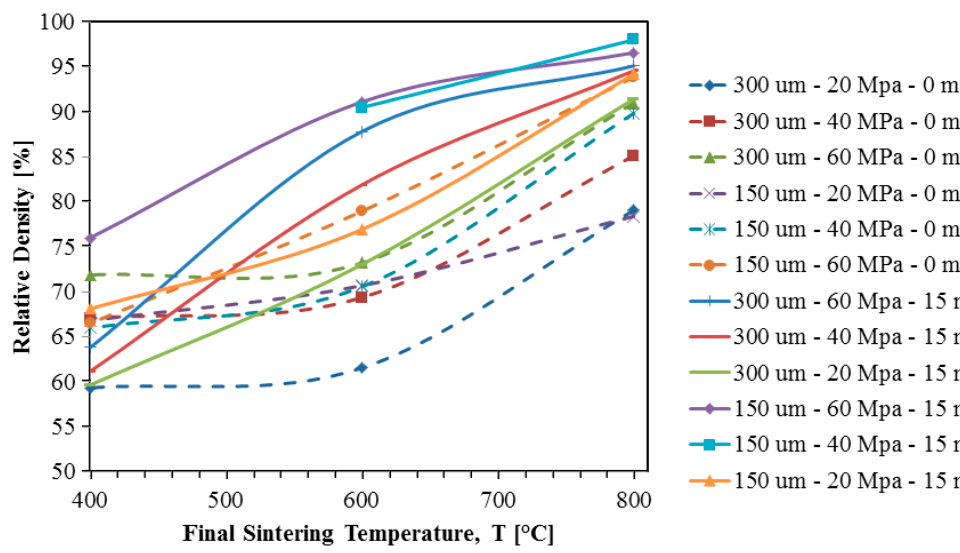
Figure 2. SEM images of ( a ) 150 μ m TNZT powder (50× and 200×) and ( b ) 300 μ m TNZT powder (50× and 200×).